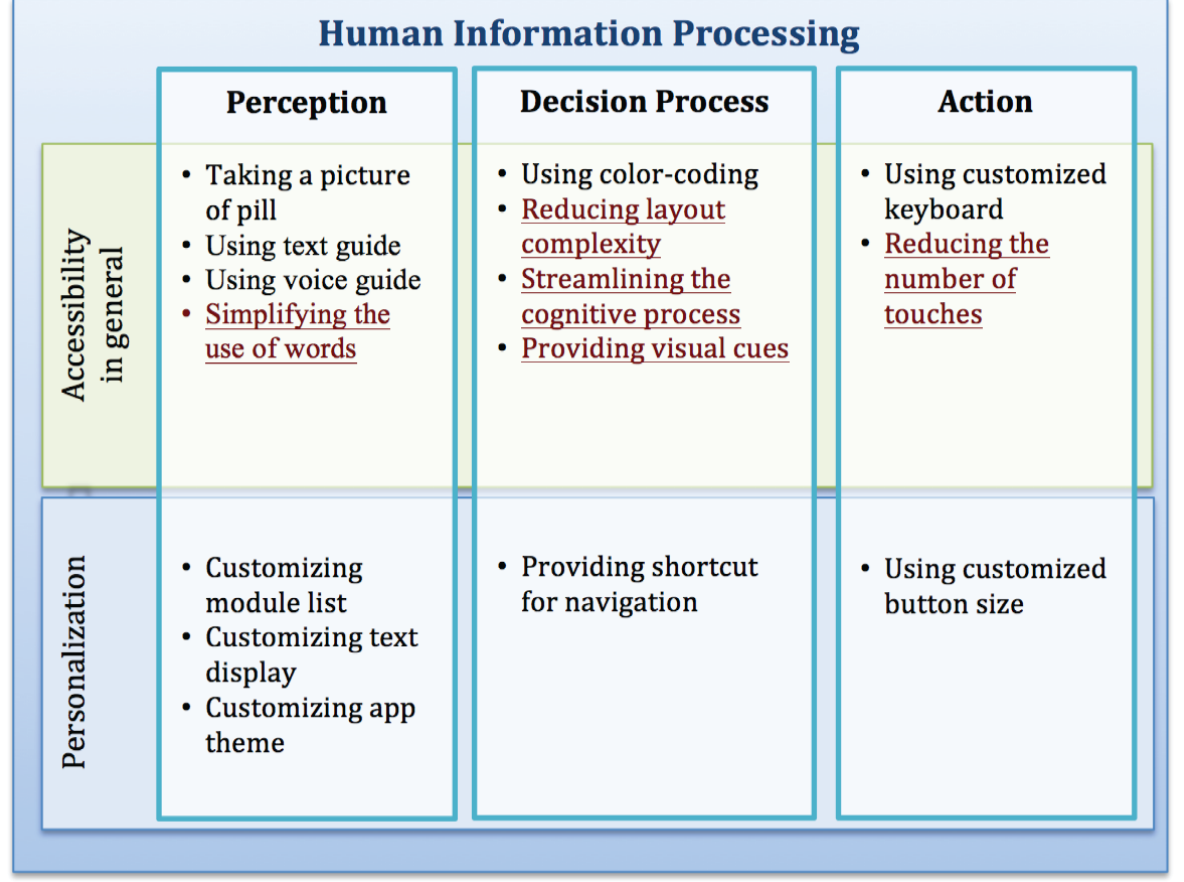
Figure 6. Accessibility